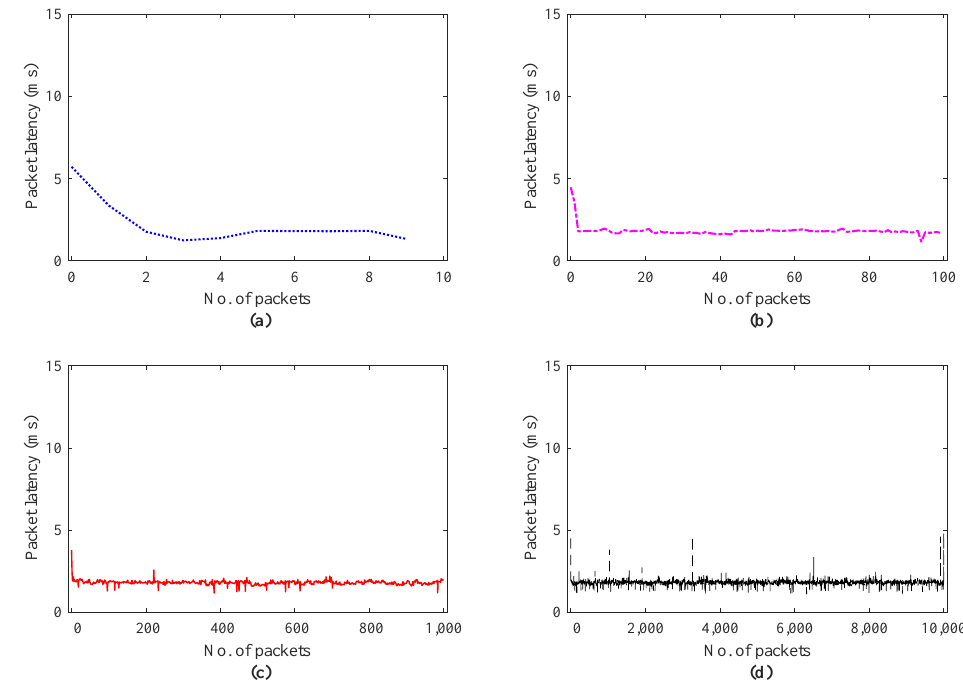
Figure 9. Packet latency investigation for scenario I haptic data transmission; ( a ) data packets = 10, ( b ) data packets = 100, ( c ) data packets = 1000, ( d ) data packets =